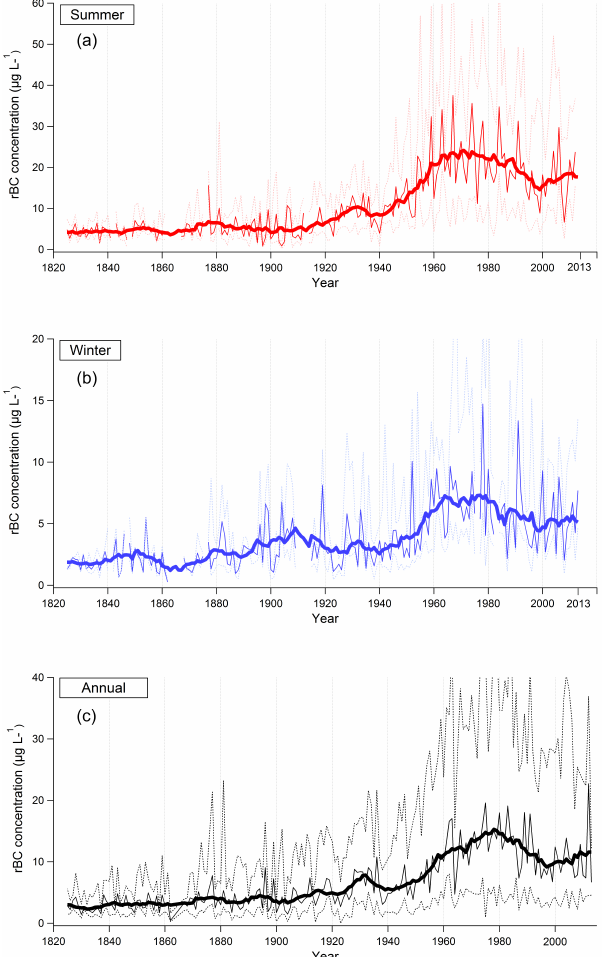
Figure 4. Annually averaged temporal evolution in the rBC mass concentration of the ELB ice cores. (a) Summer, (b) winter, and (c) annual variabilities. The thin solid line is medians and the dashed lines are the lower and upper 10th percentiles of the seasonal or an- nual rBC values. The upper 10th percentiles do not exceed 75, 35, and 56µgL − 1 for summer, winter, and annual, respectively. The thick lines are 10-year smoothing of medians. Discontinuous thin lines indicate ice layers with unclear seasonality or unanalyzed ice layers. Note the different y scales for three time series of rBC con-